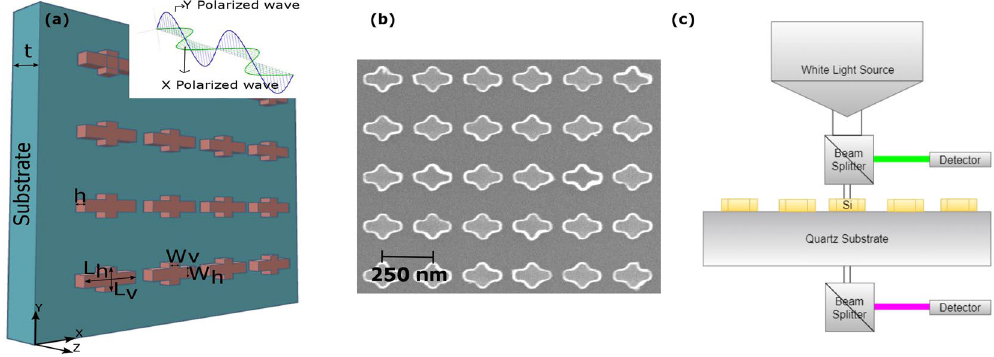
Figure 2. ( a ) Metasurface composed of nonsymmetric Si nanoantennas placed on top of quartz substrate; inset schematically shows wave propagation in case of x -polarized ( Φ = 0°) and y -polarized ( Φ = 90°) normally incident wave. ( b ) Top view of SEM image of fabricated device. ( c ) A schematic representation of the color filter operating in transmission and reflection